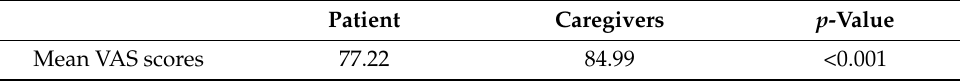
Table 6. VAS scores for patient and caregiver.